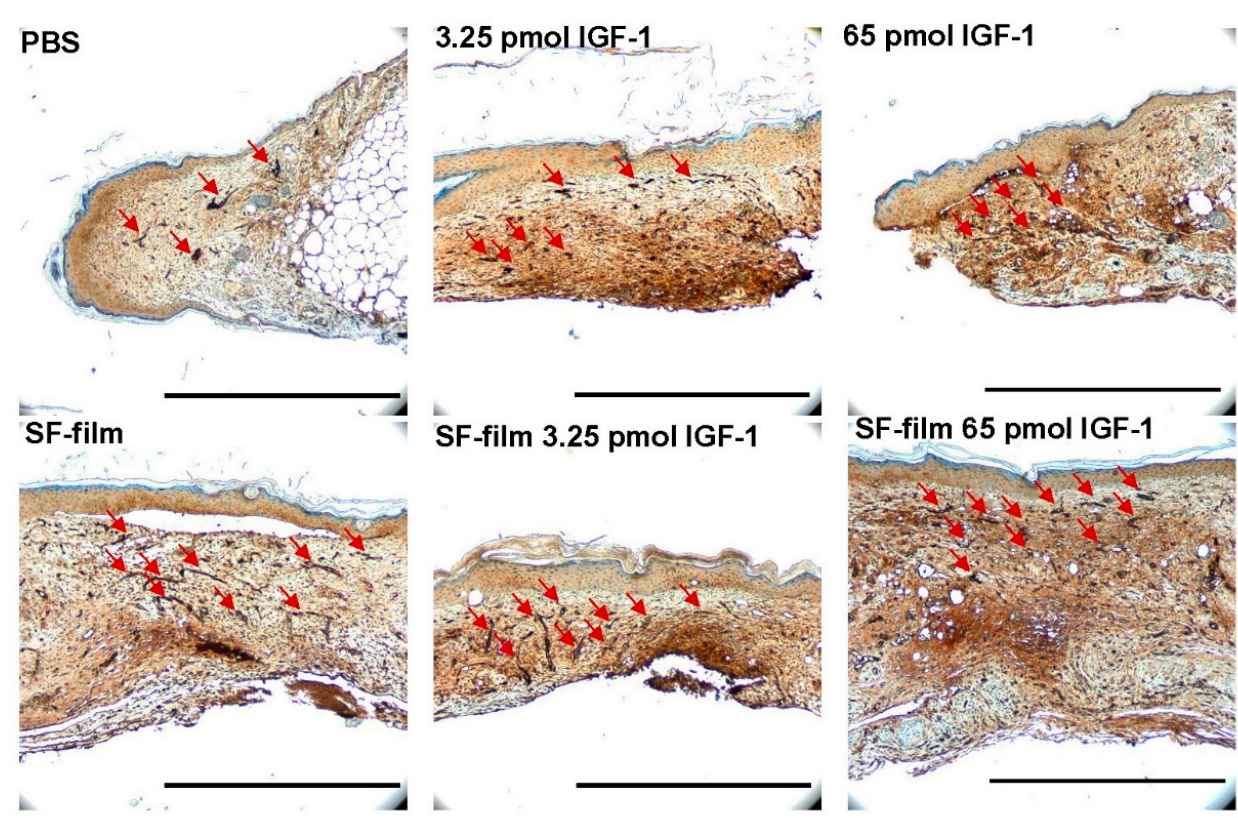
Figure 11. Effects of IGF-1, SF-film, and SF-film–IGF-1 on blood vessel growth in diabetic wounds. Blood vessel density in diabetic wounds after different treatments were determined immunohistologically by staining the tissue sections with an anti-human CD31 antibody. The presence of blood vessels is indicated by red arrows. The images were taken at 40× magnification. Scale bars = 500 µm.